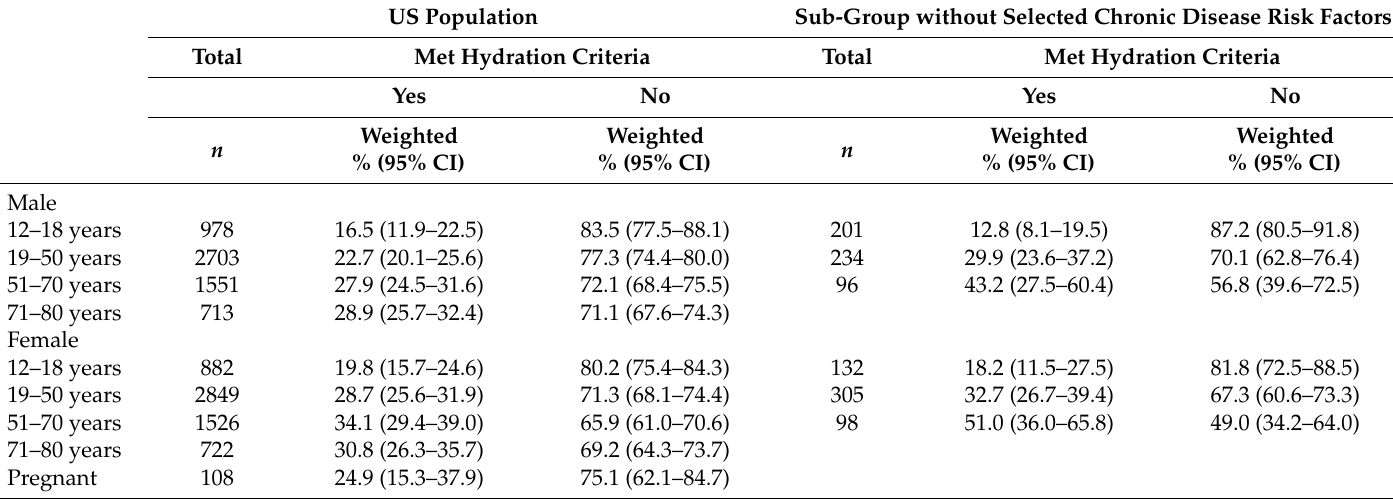
Table 3. Proportion of the US population and sub-group without selected chronic disease risk factors that met the hydration criteria in 2009–2012 by life-stage group. US